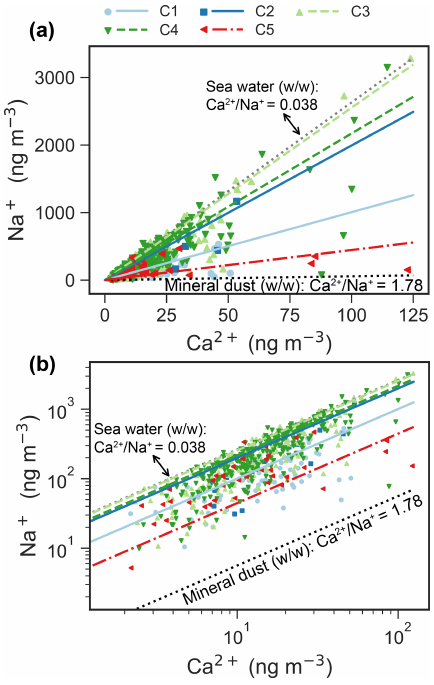
Figure 6. Scatter plot ( a : linear scale; b : log scale) of daily Na + versus Ca 2 + mass concentrations for each cluster. The ratios of Ca 2 + / Na + from sea water and Earth’s crust are denoted by dot- ted lines. The scatter points are usually in the ranges of ratios of sea water and Earth’s crustal (Bowen, 1979). The reduced major axis (RMA) regression between Na + and Ca 2 + for each cluster is su- perimposed onto the figure. The parameters of the regressions are listed in Table